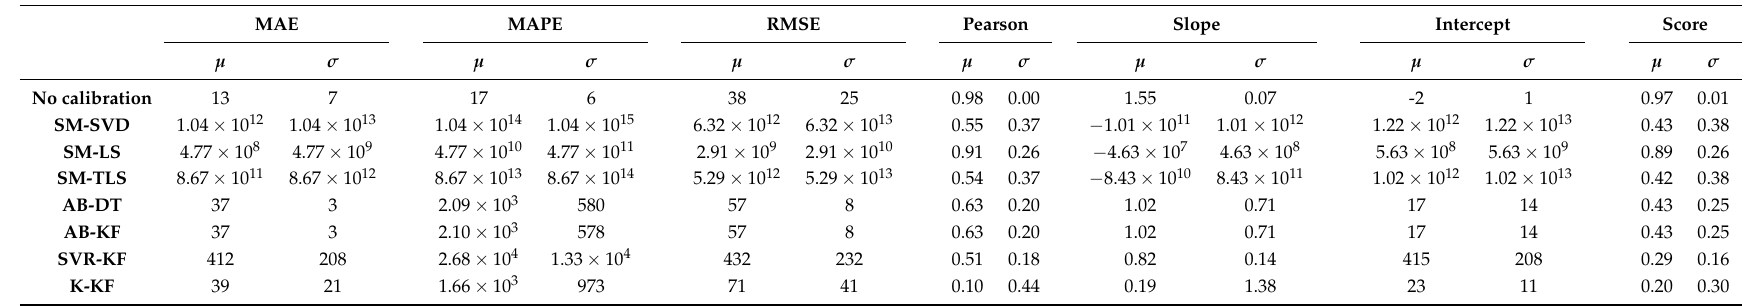
Table 9. Mean and standard deviation of each metric, computed on the entire time interval of study, over the 100 nodes of the network with the Gaussian plume model. Again, no calibration strategy allows to obtain less error than without calibration.